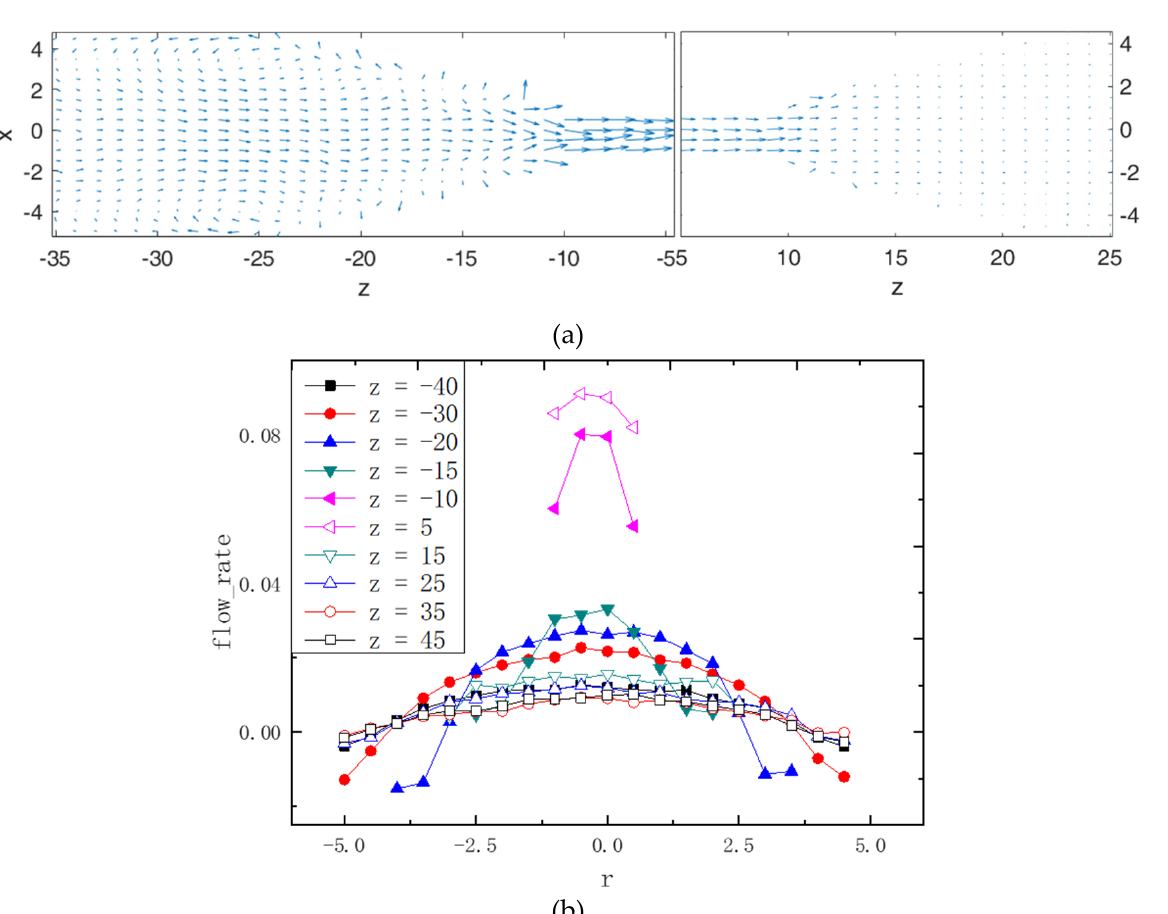
Figure 2. ( a ) 2D vector field of the velocity for the middle plane of the fluidic channel, which indicates cross − section flow field, the arrow direction indicates the flow field direction, the length and the size; ( b ) the lateral velocity along the radius direction with various z , the filled symbols indict the left channel, and the hollow symbols represent the right channel.